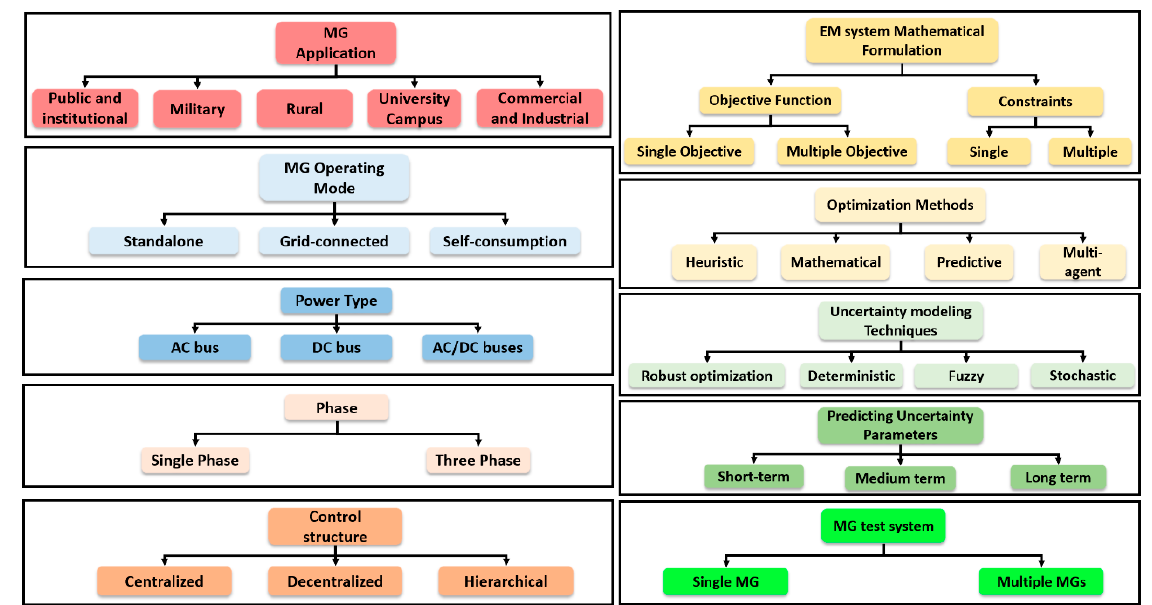
Figure 7. Control approaches for energy management systems.